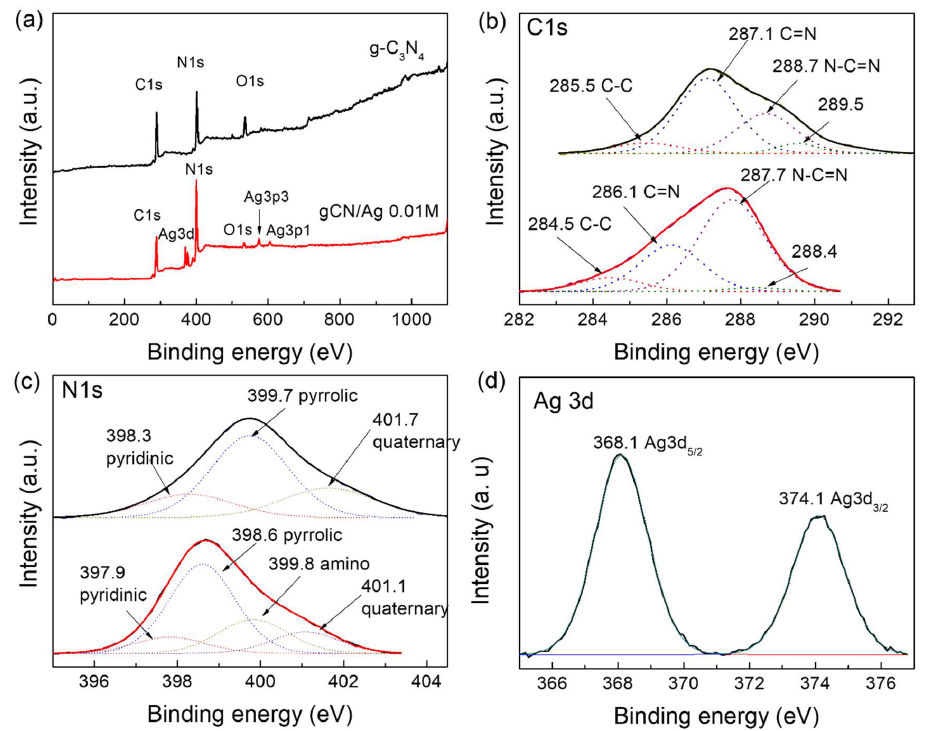
Figure 3. ( a ) XPS survey spectra. XPS spectra of ( b ) C1s, ( c ) N1s and ( d ) Ag3d of pure g-C 3 N 4 and g-C 3 N 4 /Ag 0.01M samples.